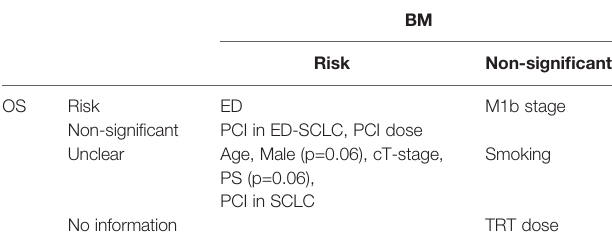
TABLE 2 | Summary of the 10 factors for BM with